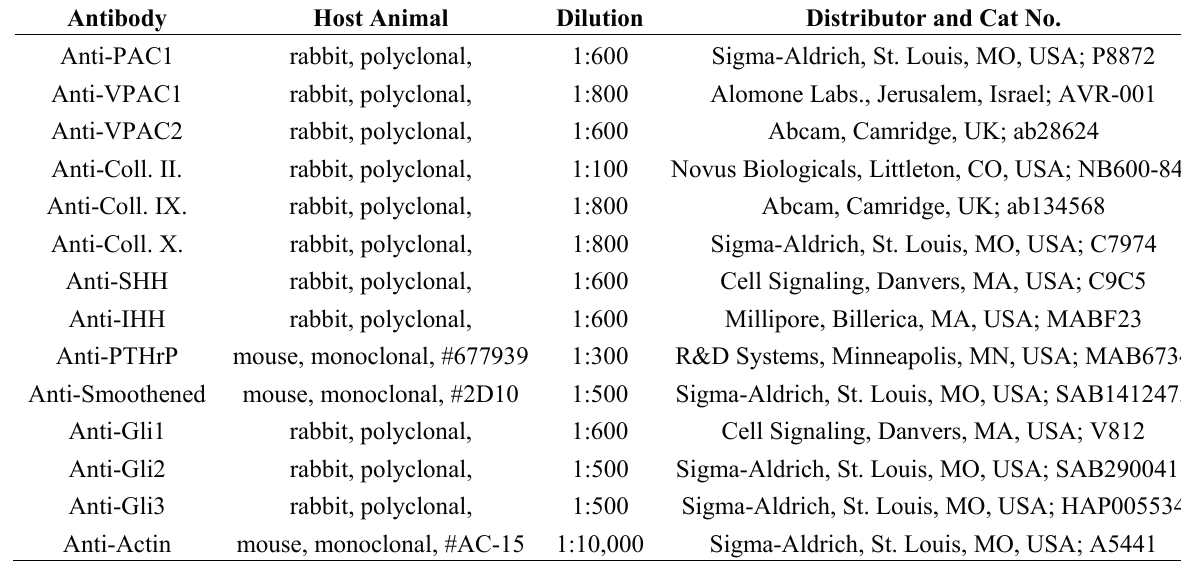
Table 2. Tables of antibodies used in the